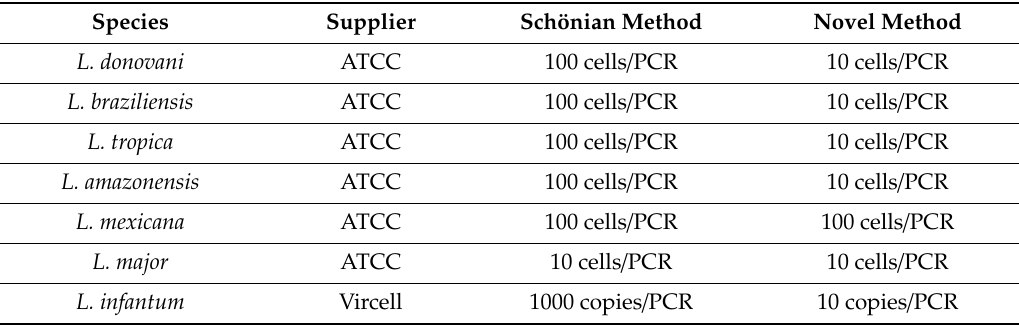
Table 2. Detection limit of the conventional and novel PCR